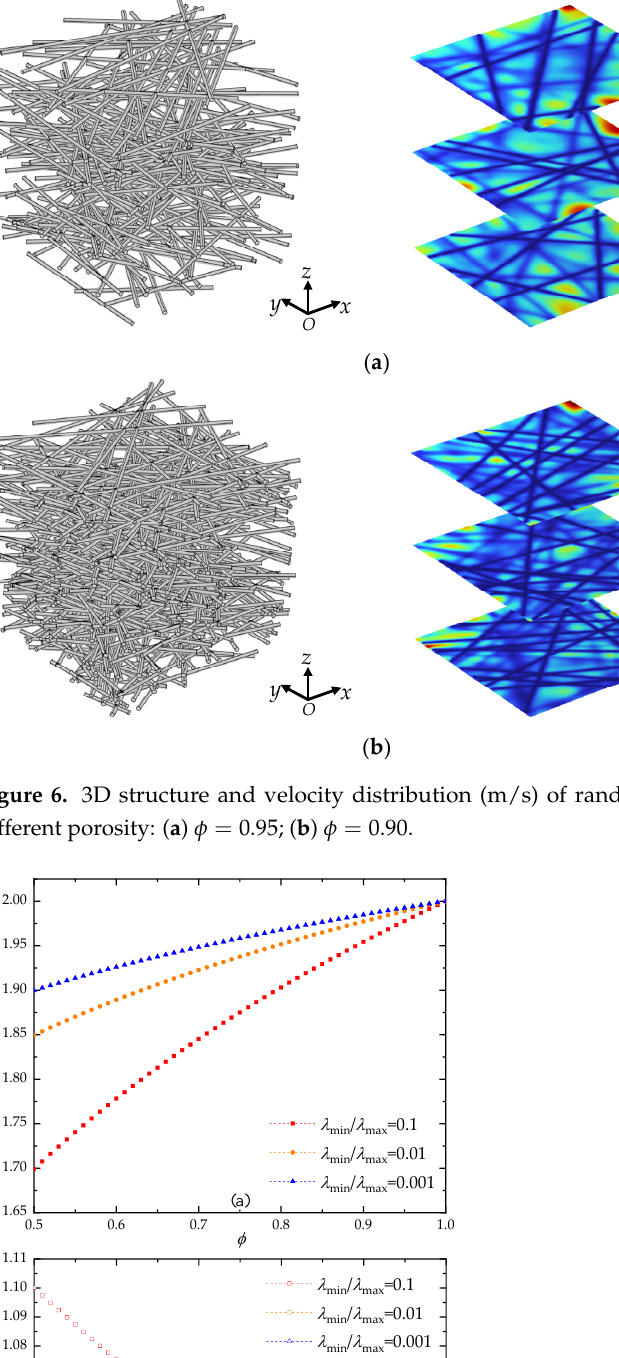
D f =2.5 D f =2.7 D f =2.9 Figure 8. The effect of pore fractal dimension on the dimensionless through-plane permeability of fibrous porous material.